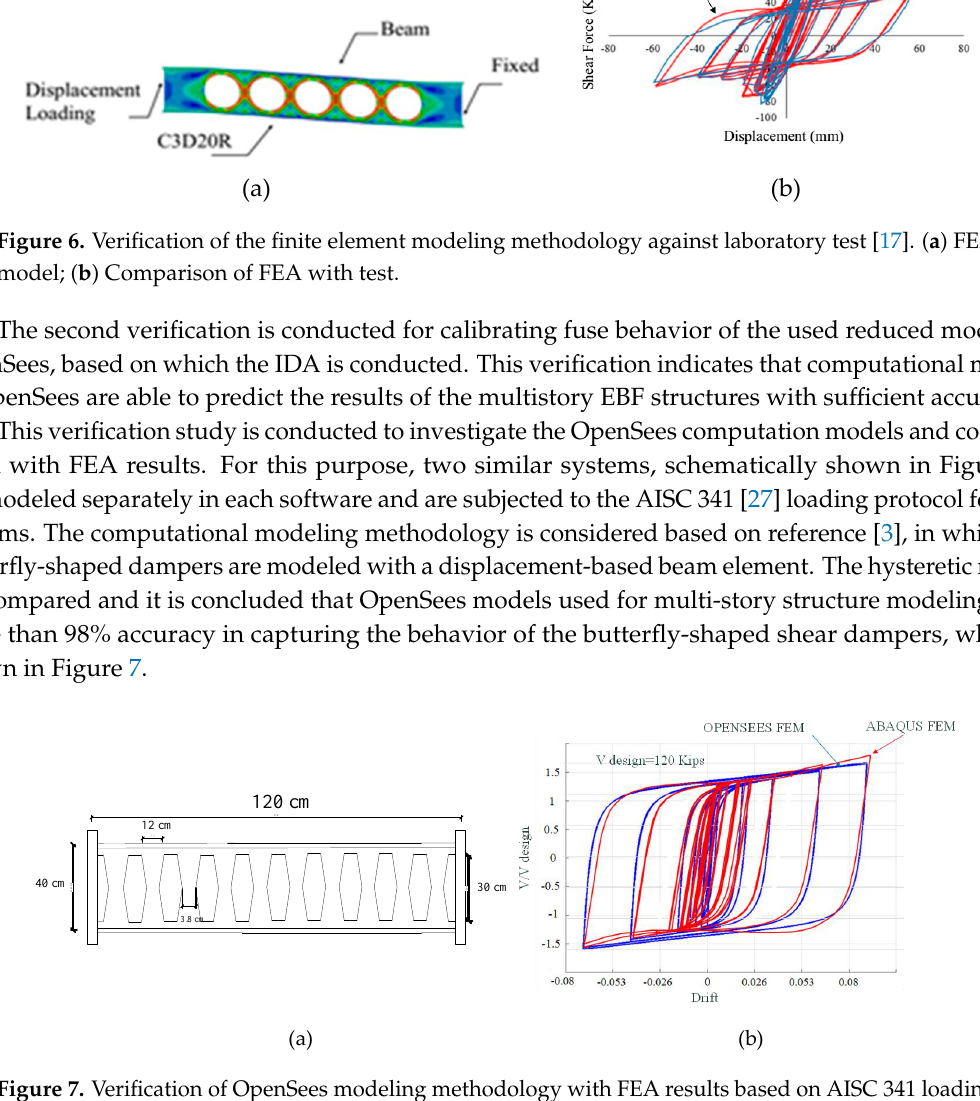
(c) Figure 5. Three design groups used for incremental dynamic analysis (IDA) (thickness is in centimeters and the rest is in meters). ( a ) Category I, for lower story structural fuses based on W 10 × 68 beam dimensions; ( b ) Category II, for middle story structural fuses based on BU13 × 53 beam